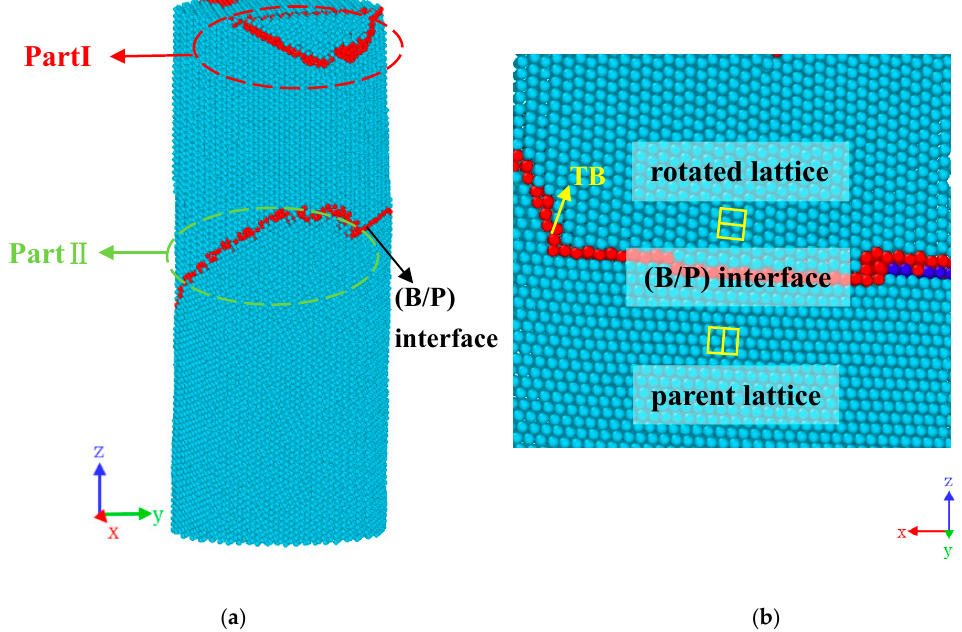
Figure 5. ( a ) Configurations shown for the TB migration at the compressive strain of 0.047. ( b ) A magnified picture of basal/prismatic (B/P) interface.